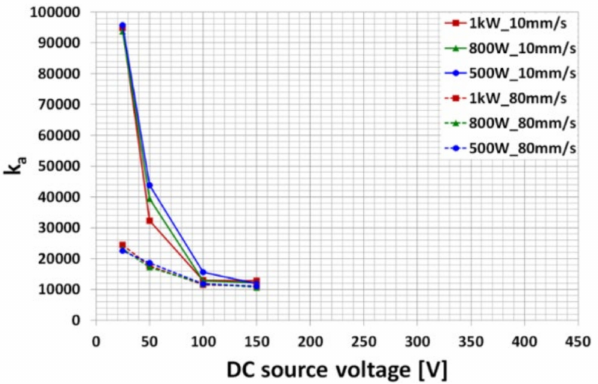
Figure 5. Arc empirical constant k a under separation speed, source voltage, and load power levels (Source voltage < 200